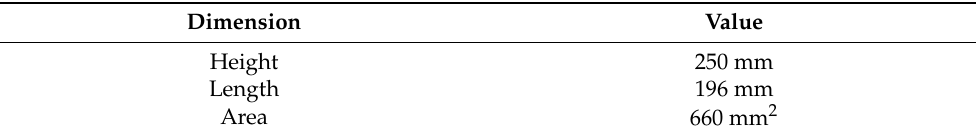
Figure 3. Human geometry: ( a ) Human body (1.8 m tall); ( b ) Face shield in detail. Table 1. Face shield